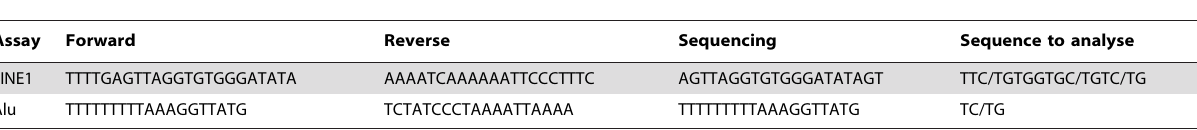
Table 2. Overview of primers and sequences for pyrosequencing assays.